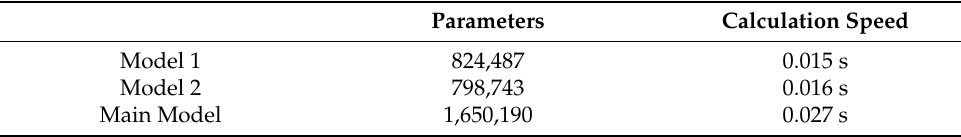
Table 6. The average calculation speed of